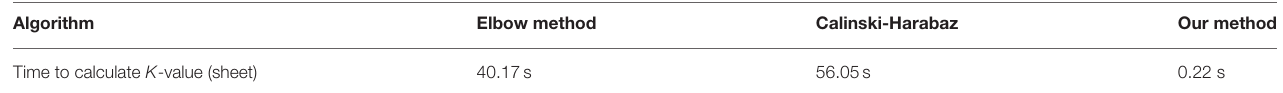
TABLE 2 | The calculation time of the cluster value K . Algorithm Elbow